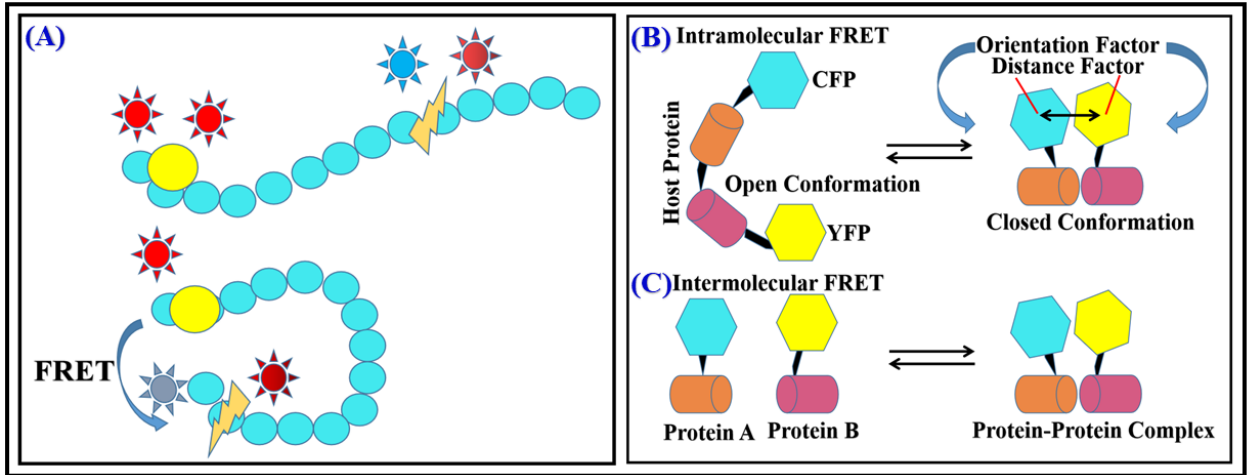
Figure 1. ( A ) FRET during protein conformational change. ( B ) Intramolecular (C) Intermolecular